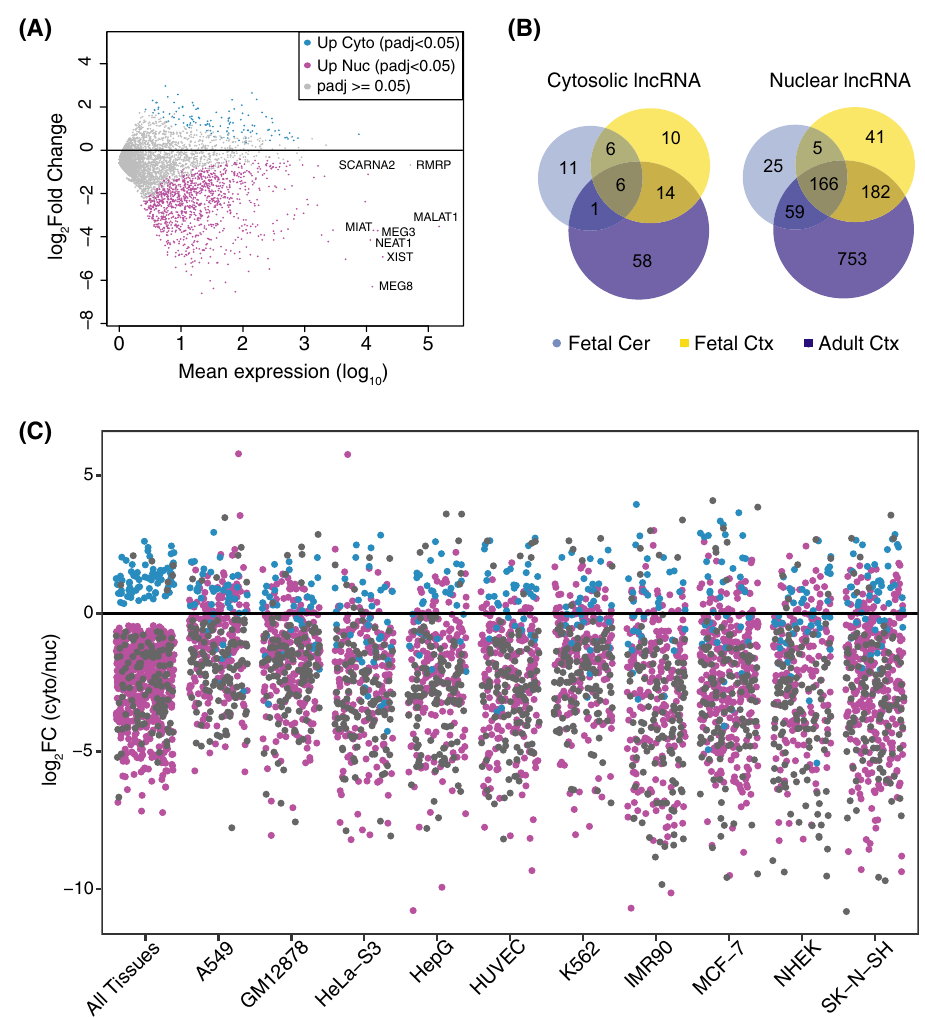
Figure 3. Cytosolic and nuclear distribution of lncRNAs (A) MA plot showing global (all tissues) distribution of differentially localized lncRNA genes in the cytosol (blue) and nucleus (magenta). Non-significant lncRNA genes are highlighted as grey. (B) Venn diagram displaying overlapping lncRNA genes differentially localized in the fetal cerebellum (light blue), fetal cortex (yellow) and adult cortex (purple). (C) Strip chart showing localization of significantly cytosolic (blue) and nuclear (magenta) lncRNAs from our data (all tissues combined) and in ENCODE cell lines (baseMean ≥ 10). Only differentially expressed lncRNAs in cell lines overlapping with all-tissue DEGs are shown. Genes that remained consistently cytosolic or nuclear in the brain samples and cell lines are highlighted in